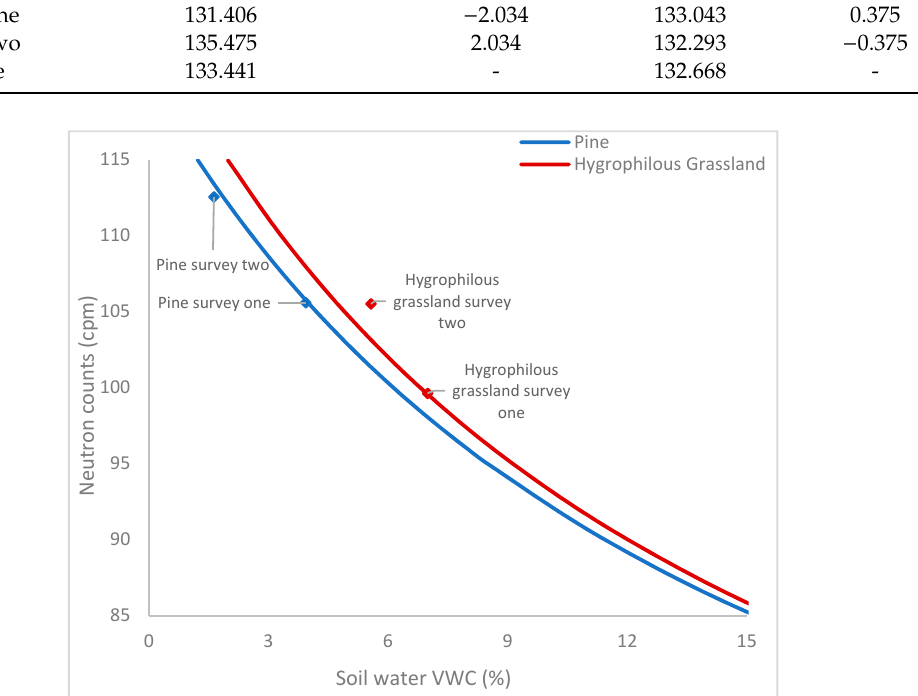
Figure 6. Calibration curve of the hygrophilous grassland and pine sites.